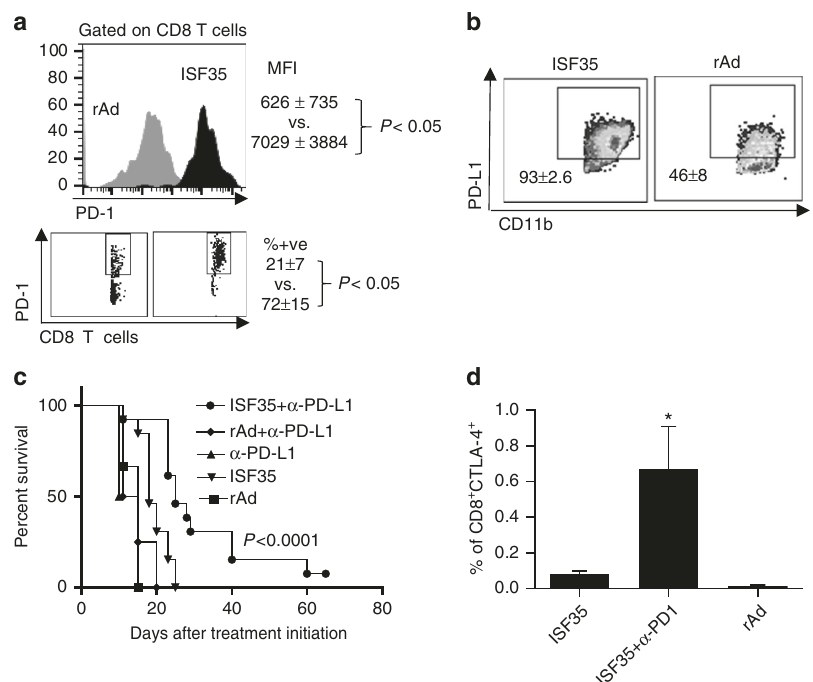
Fig. 4 Antitumor effect of intratumoral ISF35 and anti-PD-1 antibody combination therapy. Mice bearing 8-day s.c. B16.F10 tumors were treated as indicated, and tumor-in fi ltrating leukocytes were stained after 5 days of treatment and analyzed by fl ow cytometry for the expression of PD-1 and PD-L1. a Mean fl uorescence intensity (MFI) and percentage of CD45 + CD8 + PD-1 + cells. b Percentage of CD45 + CD11b + PD-L1 + cells. c Mice bearing 8-day s.c. B16.F10 tumors were treated with i.t. ISF35 or rAd and anti-PD-L1. The graph depicts tumor growth at different time points. d Percentage of CD8 + CTLA-4 + cells after indicated treatment. Data are analyzed by unpaired two-tailed t test or one-way ANOVA. * P < 0.05, ** P < 0.005 ( n = 4 – 8 mice). Error bars are SEM. Survival analysis was performed with the log-rank